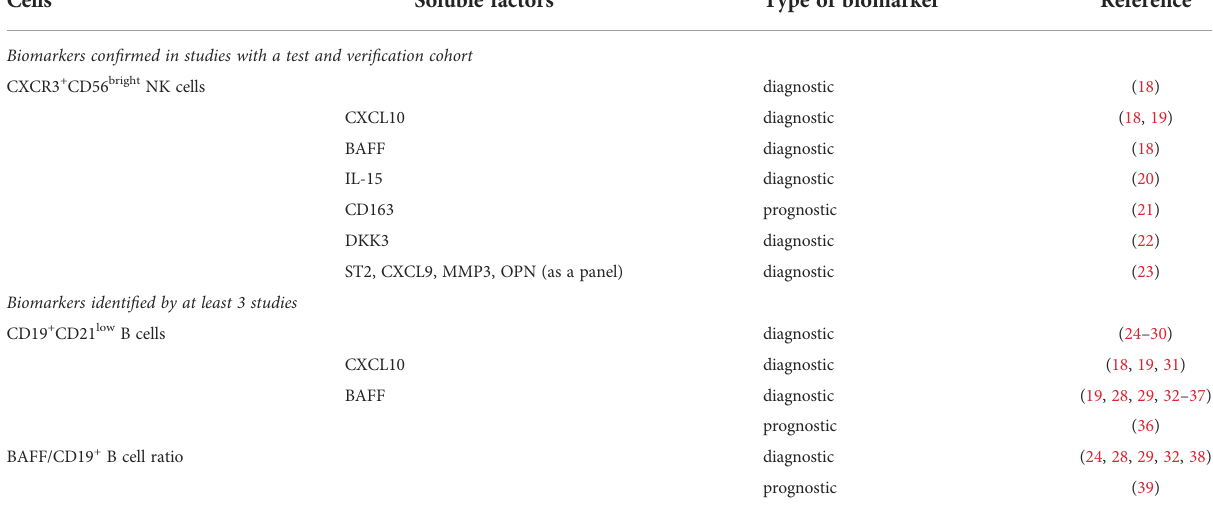
TABLE 2 Summary of most promising biomarkers of cGvHD.